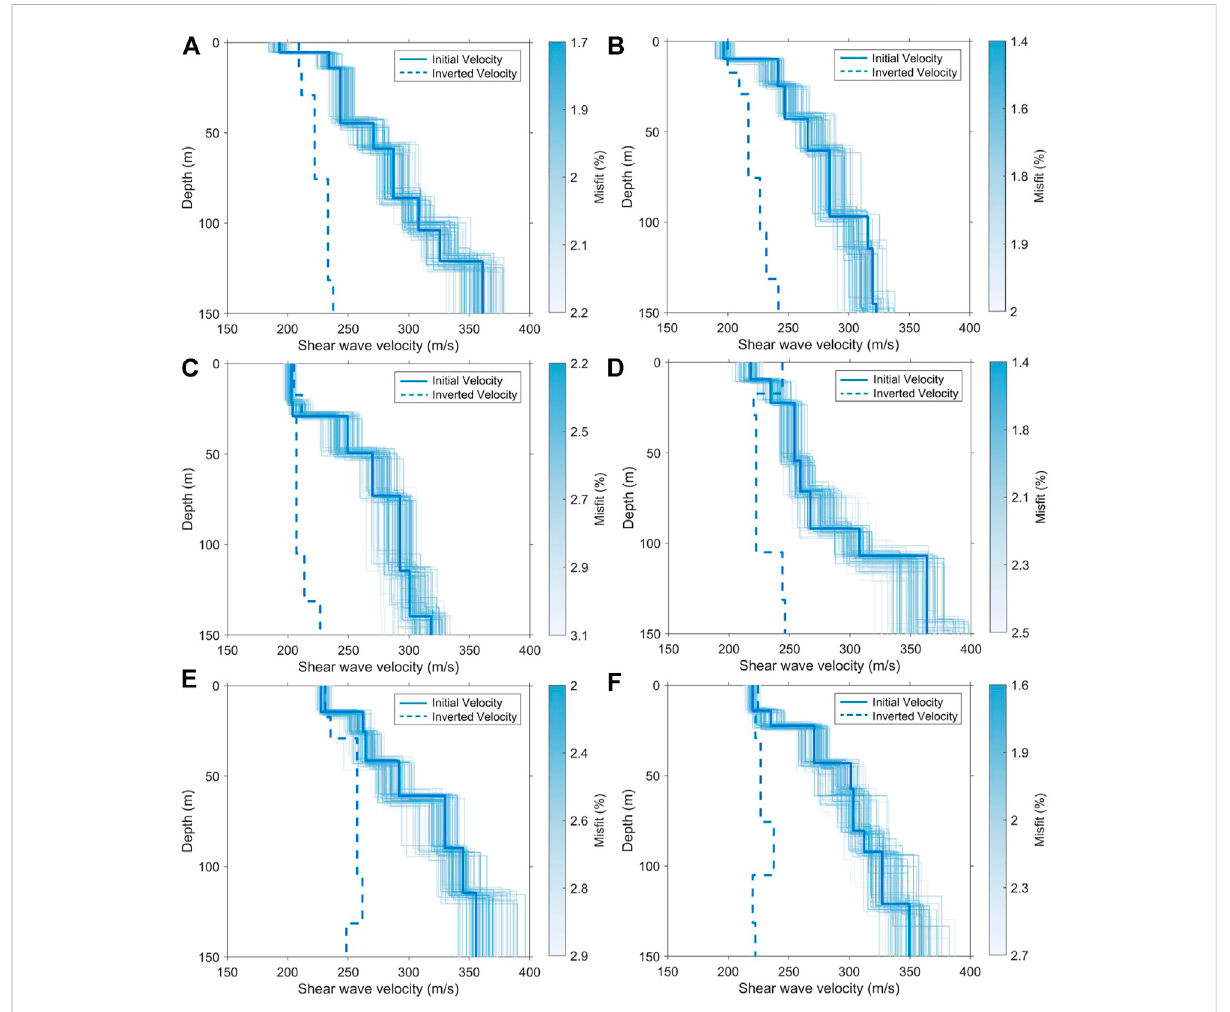
Figure 11. We compared the fi nal velocity pro fi le with the prior geological information in the study site to validate the result. The previous study shows that the quaternary deposits in the study area include the Holocene and Pleistocene sequences (Zhao et al., 2019). Boundaries of the Holocene-Upper Pleistocene, the Upper-Middle Pleistocene, and the Middle-Lower Pleistocene are respectively located at depths of 17.35, 57.20 and 75.60 m. These stratigraphic boundaries are approximately consistent with those in the inverted velocity, as shown in the color bar in Figure